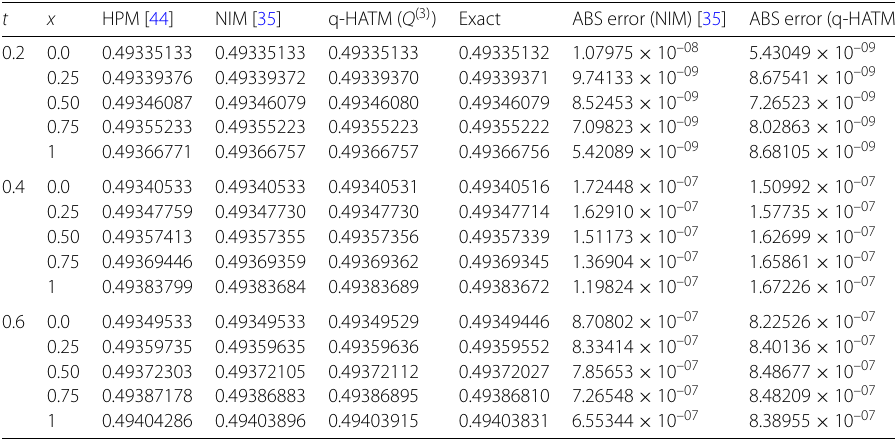
Table 3 The comparison of numerical result of Q ( x , t ) obtained by NIM [35], HPM [44], q-HATM, and the exact solution Equation (32), also the absolute (ABS) errors when α = 1, (cid:2) = –0.99, k = η = 0.1, p = 1.5, r = –1.5, and n = 1 for Example 4.1